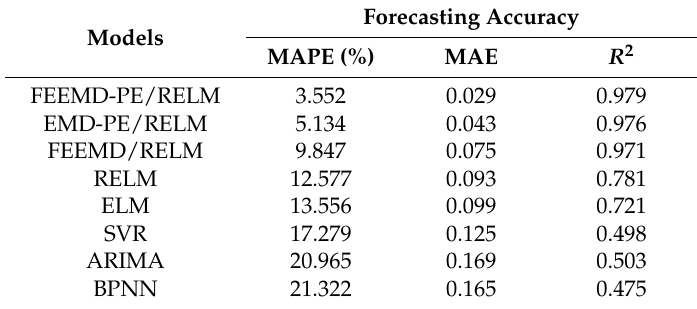
Figure 10. Analysis of degradation tendency measuring results in terms of mean absolute percentage error (MAPE), mean absolute error (MAE), and coefficient of determination ( R 2 ). Table 5. Forecasting accuracy comparison of the eight models. RELM—regularized extreme learning machine; MAPE—mean absolute percentage error; MAE—mean absolute error; R 2 —coefficient of determination.